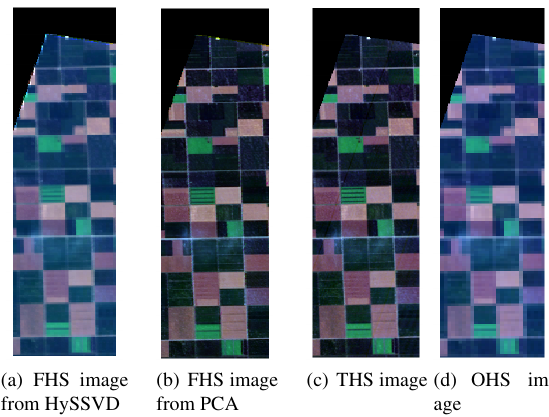
Figure 6: Magnified view of the selected part of the Study Area Image Type